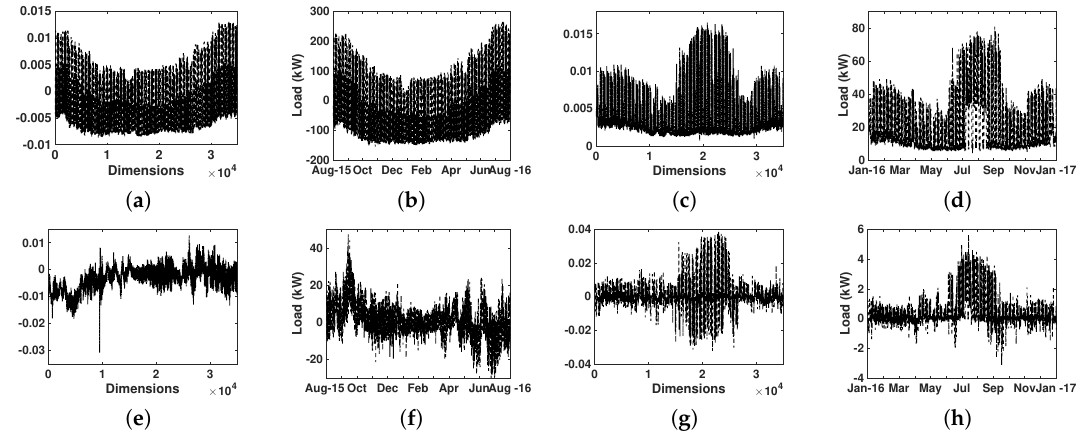
Figure 7. Orthonormal partial least squares (OPLS) load prediction for Hospital Universitario de Fuenlabrada (HUF) ( a , b , e , f ) and for Centro de Especialidades El Arroyo (CEA) ( c , d , g , h ). For the HUF model, the first and second eigenvectors ( a , e ) are represented together with their coefficient projection on the test year ( b , f ). Similar plots for CEA are shown in terms of the two first eigenvectors ( c , g ) and their coefficient projections ( d , h